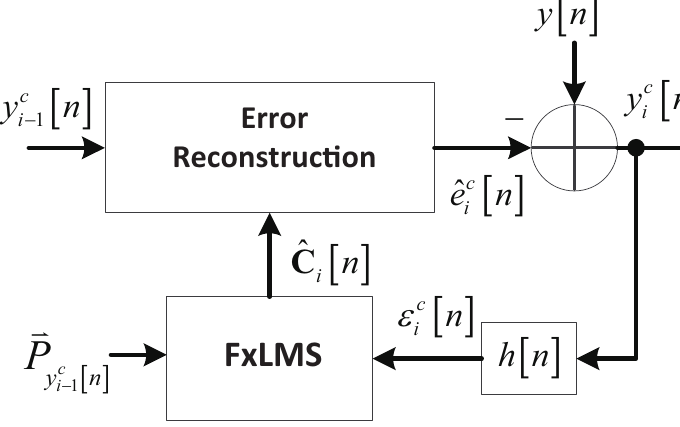
Figure 6. The structure of the i -th stage calibration